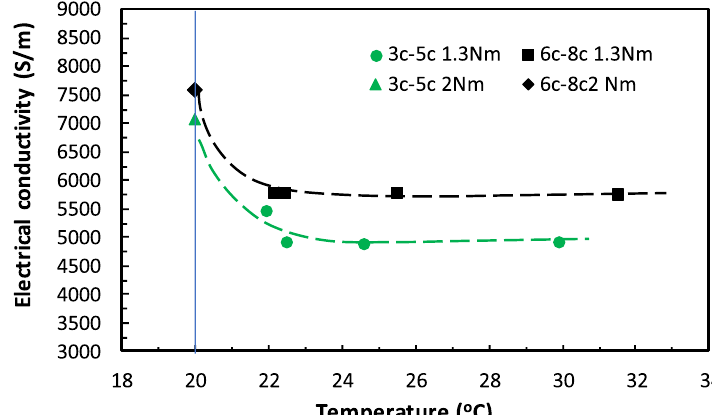
Fig. 13 Electrical conductivities of painted carbon/epoxy laminates in in-plane direction